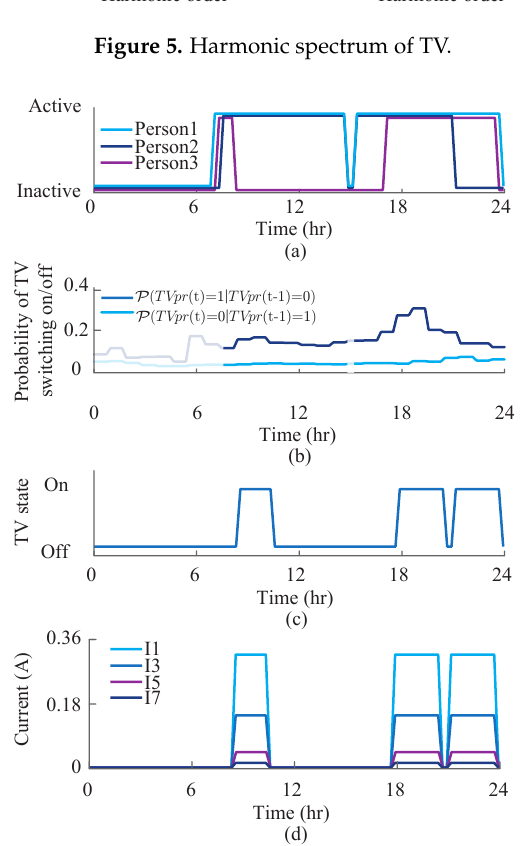
Figure 6. Harmonic modeling process for TV in a house with three persons. ( a ) The occupancy profile of the house; ( b ) the Markov chain probabilities of TV switching on/off; ( c ) the on/off states of TV; and ( d ) the fundamental, 3rd, 5th and 7th harmonic